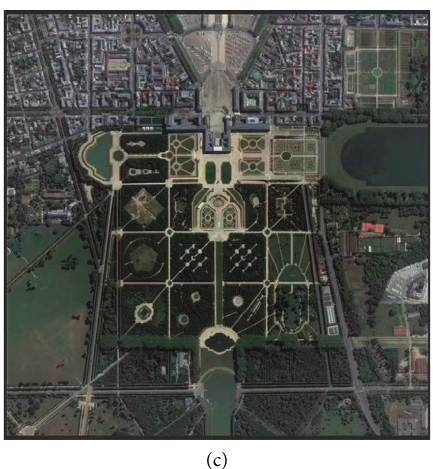
Figure 4: Image adaptive enhancement results of three algorithms. (a) The adaptive enhancement results of the algorithm in this paper. (b)